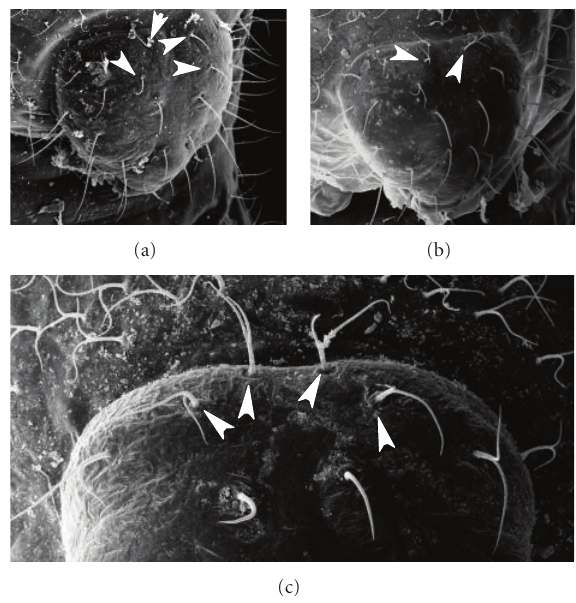
Figure 8: Head hairs ( = setae) of fourth instar larvae from di ff erent fire ant species. Medial hairs of second row of vertex and occipital region are indicated with arrowheads . (a) Solenopsis saevissima with medial hairs simple (compare with Figures 4(b), 5(b), and 6(b), in which specimens had bifid hairs). (b) Solenopsis invicta with bifid hairs. (c) Solenopsis geminata with bifid hairs. Respective sizes of scale bars ( µ m): 80, 100, and